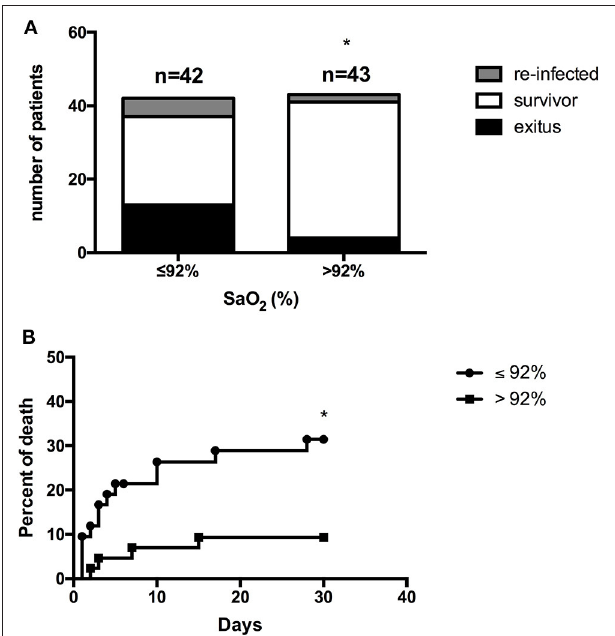
FIGURE 1 | Frequency of survivors, survivors re-infected and exitus in patients with sepsis classified according to their oxygen saturation.Patients with sepsis ( n = 85) were classified into two groups according to their oxygen saturation (SaO 2 ) on admission ( ≤ 92% and > 92%), and were followed up for 1 month. (A) The number of survivors, survivors who had at least one reinfection episode and exitus are reported. * χ ² = 13.078; P = 0.001. (B) The percentage of death accumulated is shown. * χ ² = 5.708; P = 0.017.